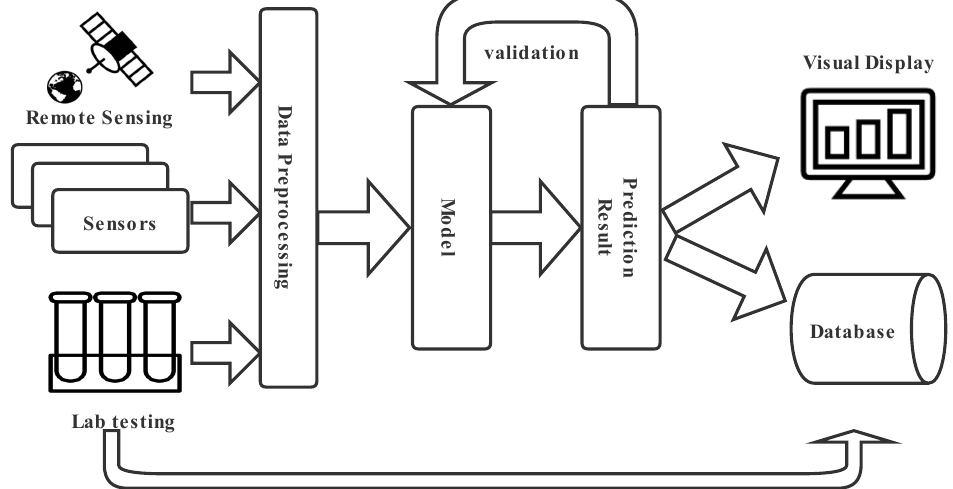
Figure 1. Water quality prediction framework for inland and nearshore